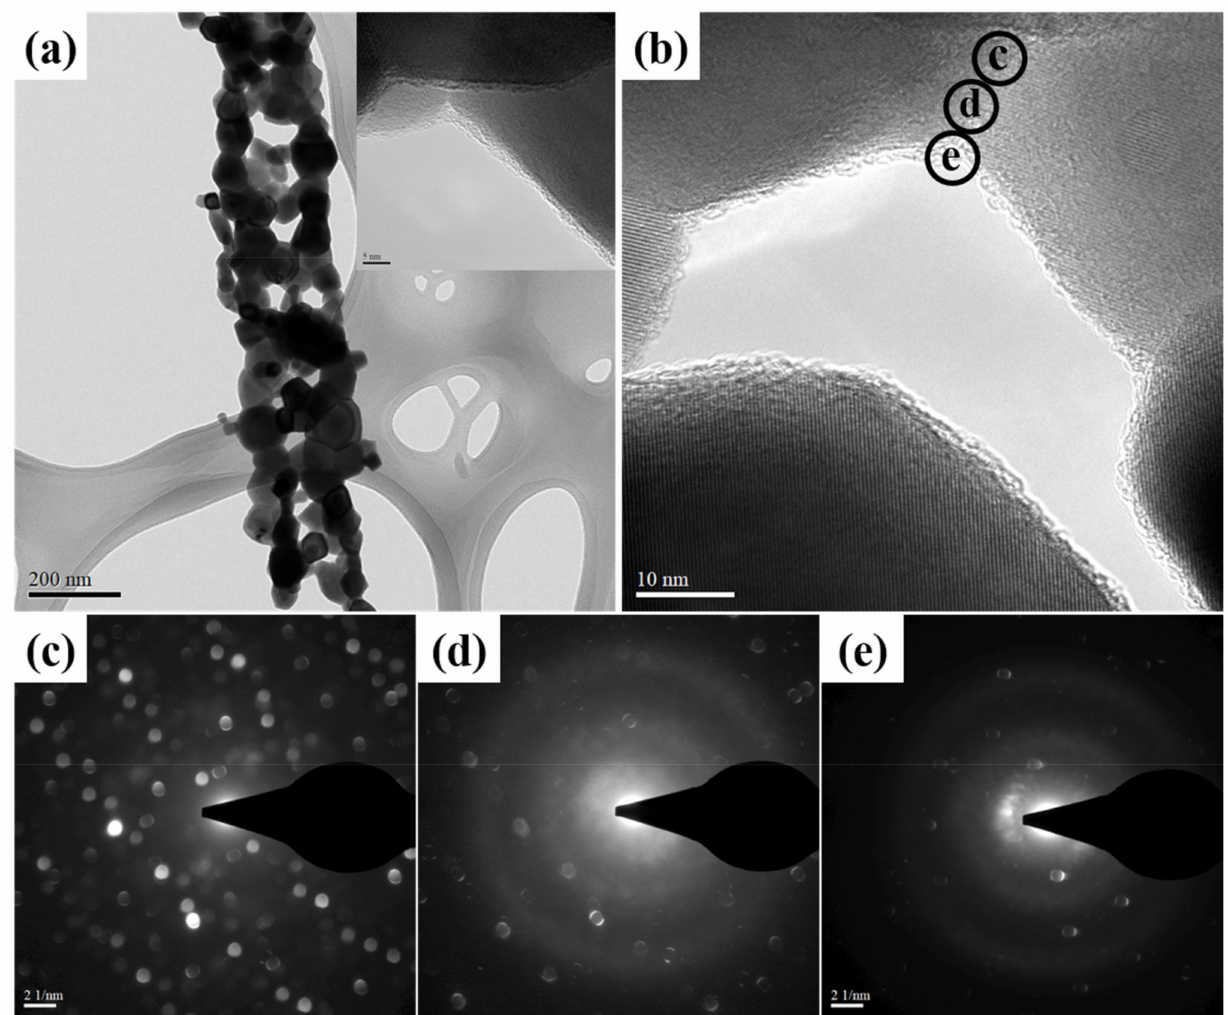
Figure 2. ( a ) TEM image of hollow C#In 2 O 3 nanofibers. ( b ) High-magnification TEM image of hollow C#In 2 O 3 nanofibers. Nano beam diffraction (NBD) images of selected area ( c – e ) in Figure